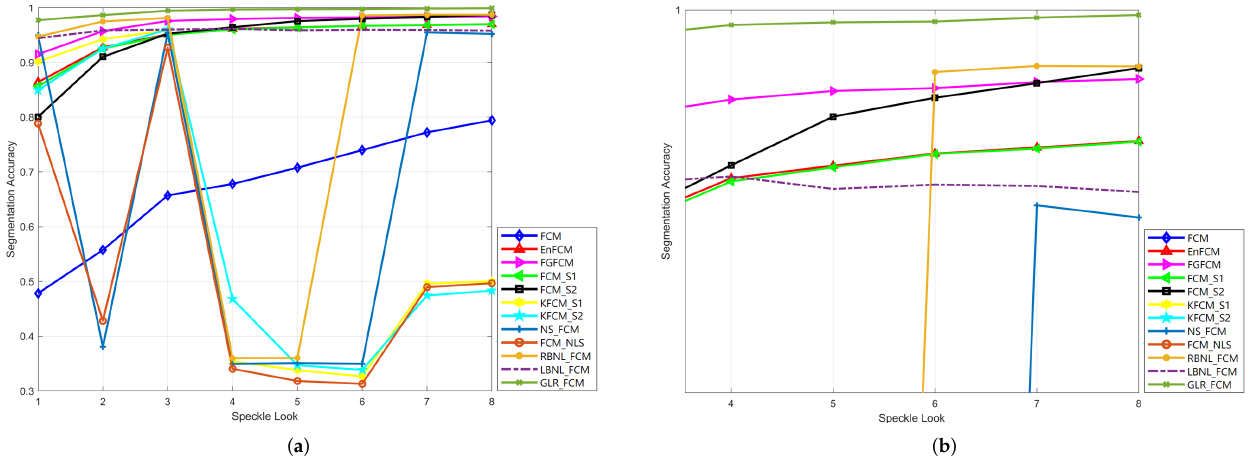
Figure 17. The segmentation accuracy of different algorithms testing on the first simulated SAR image with adding speckle noise of different looks. ( a ) SA curves of different methods. ( b ) The partial enlarged view of ( a